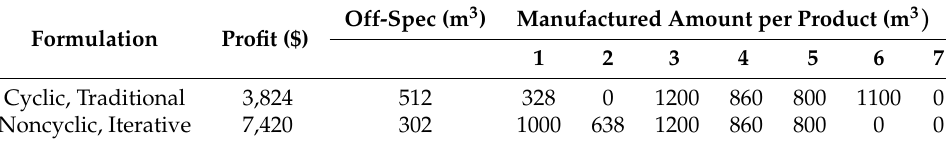
Table 14. Economic results: Scenario 2.